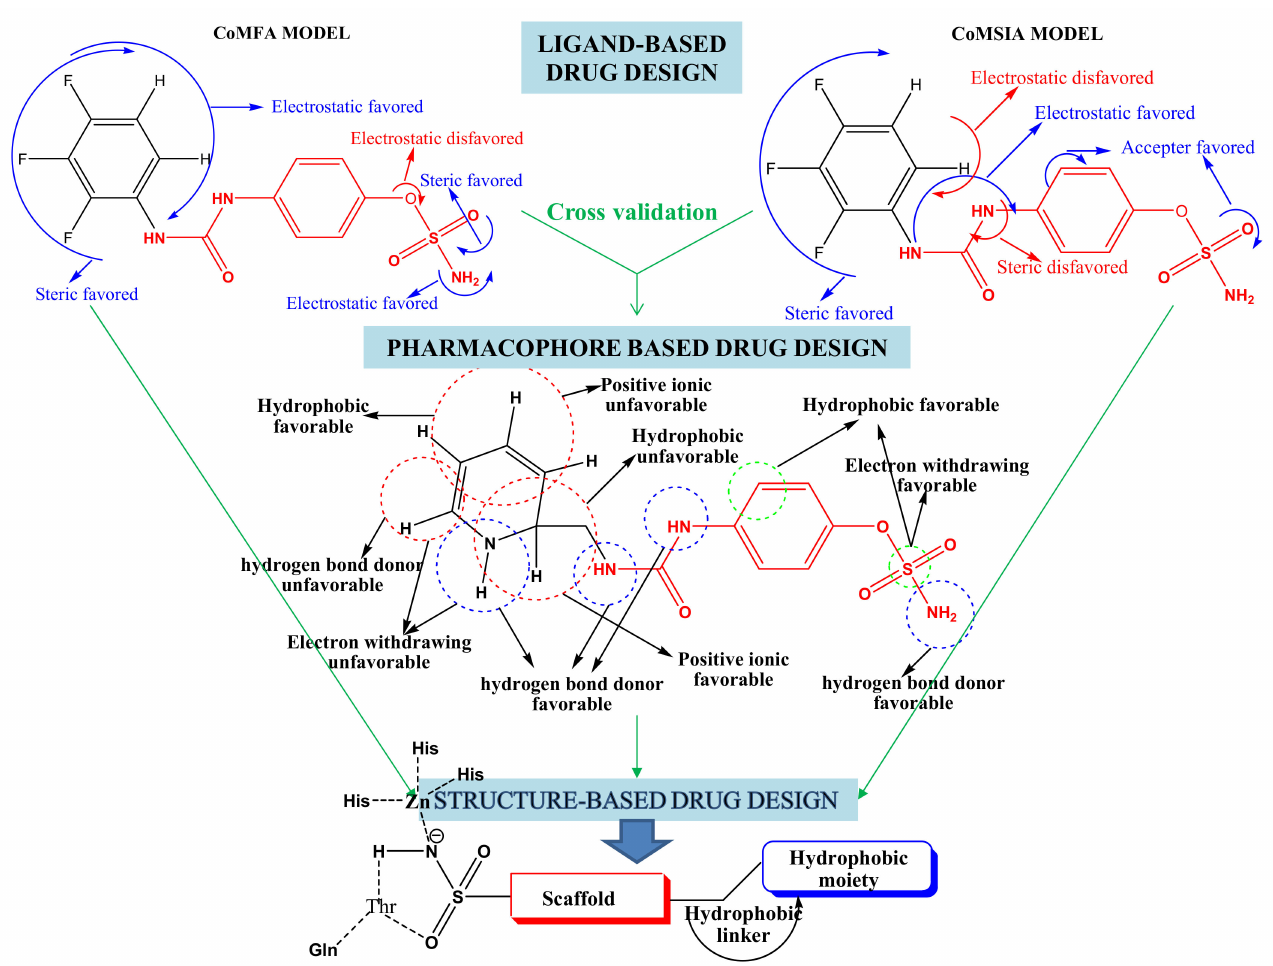
Figure 2. Resulting designed structural element (HIT) as hCA inhibitor from the outcome of ligand and structure-based drug design (CoMFA, CoMSIA, and pharmacophore modelling)